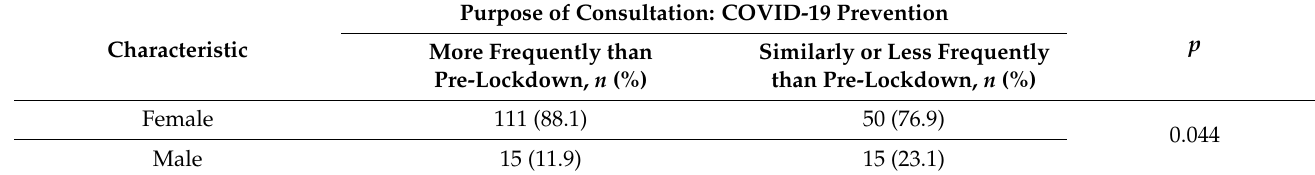
Table 5. The gender-based distribution of respondents indicating that the purpose of consultation was COVID-19 prevention.